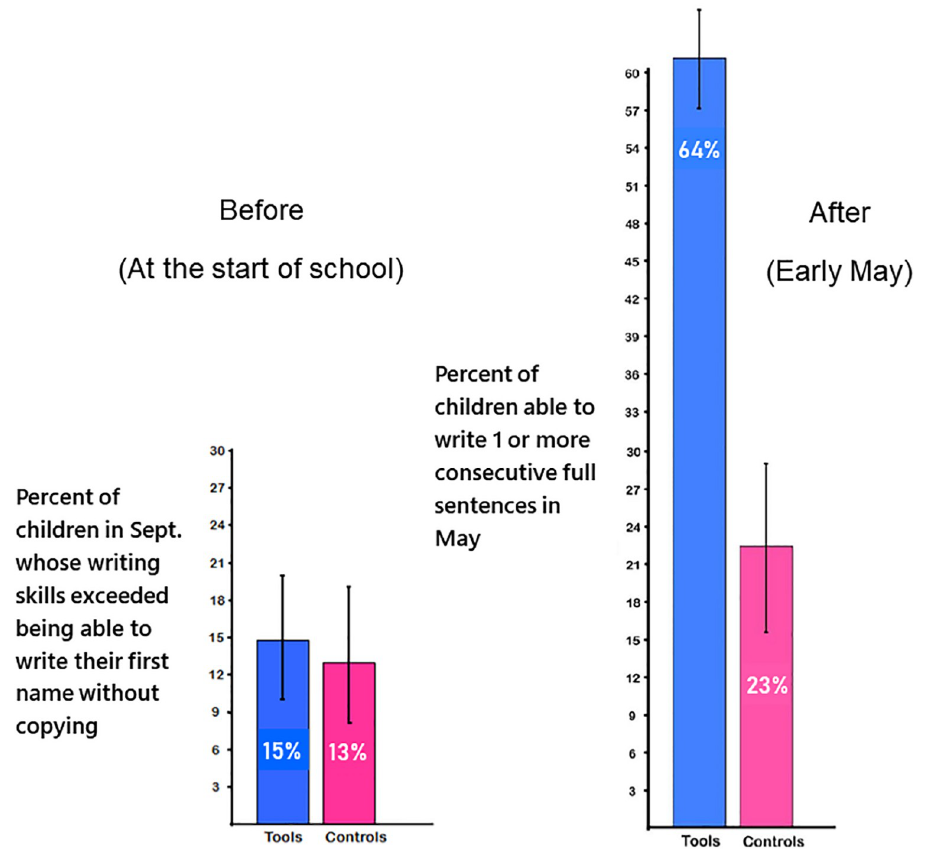
Fig 2. Writing skills. By May, three times more children in Tools than in control classes were able to write a full sentence they themselves composed or multiple consecutive ones (F[1,15] = 18.10, p < 0.001, η p 2 =